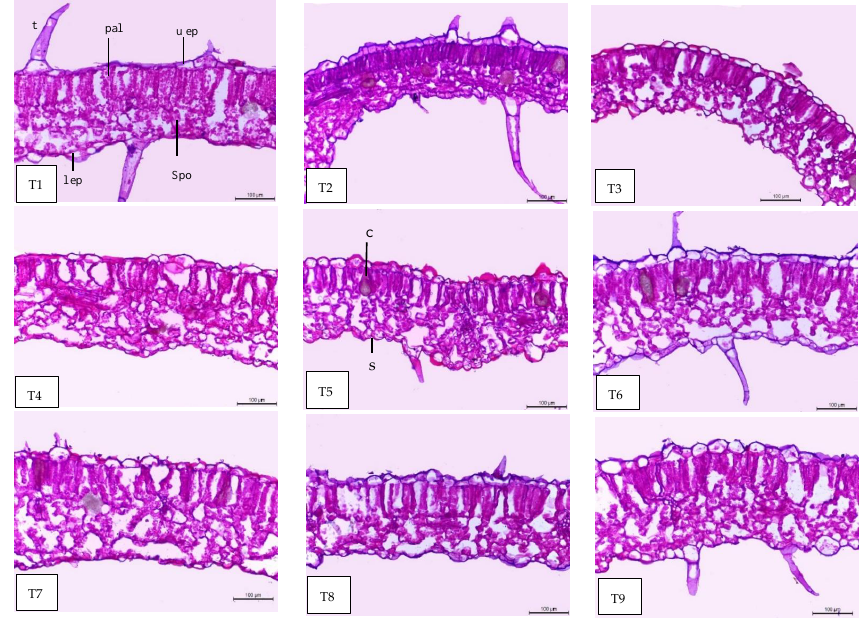
Figure 9. Magnified portions of the leaf blade lamina of tomato plants, aged 60 days. Scale bars = 100 µm. T1 — self-grafted Peto 86 as a control; T2 — Peto 86/ S. cheesmaniae; T3 — Peto 86/GS hybrid; T4 — Peto 86/Peto 86 + SA; T5 — Peto 86/ S. cheesmaniae + SA; T6 — Peto 86/GS hybrid + SA; T7 — Peto 86/Peto 86 + S. griseus ; T8 — Peto 86/ S. cheesmaniae + S. griseus; T9 — Peto 86/GS hybrid + S. griseus. Details: l ep, lower epidermis; spo, spongy tissue; pal, palisade tissue; u ep, upper epidermis; t, trichome; c, cells with dark content containing calcium oxalate crystals; s, stomata.